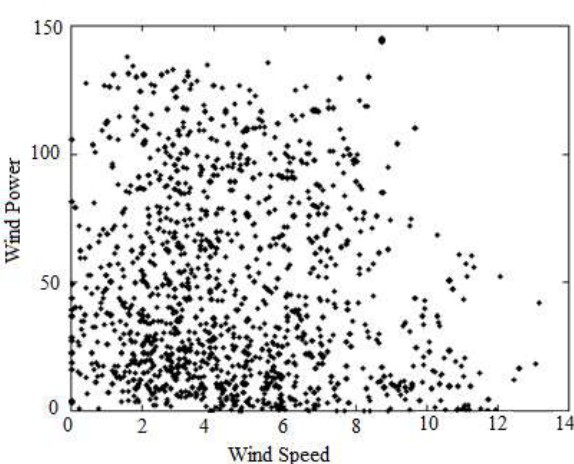
Figure 2. Bifurcation diagram of wind speed versus